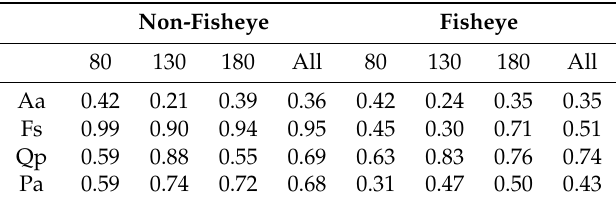
Table 2. RMSE% of perimeter estimation (Aa: Abies alba ; Fs: Fagus sylvatica ; Qp: Quercus petraea ; Pa: Picea abies ).